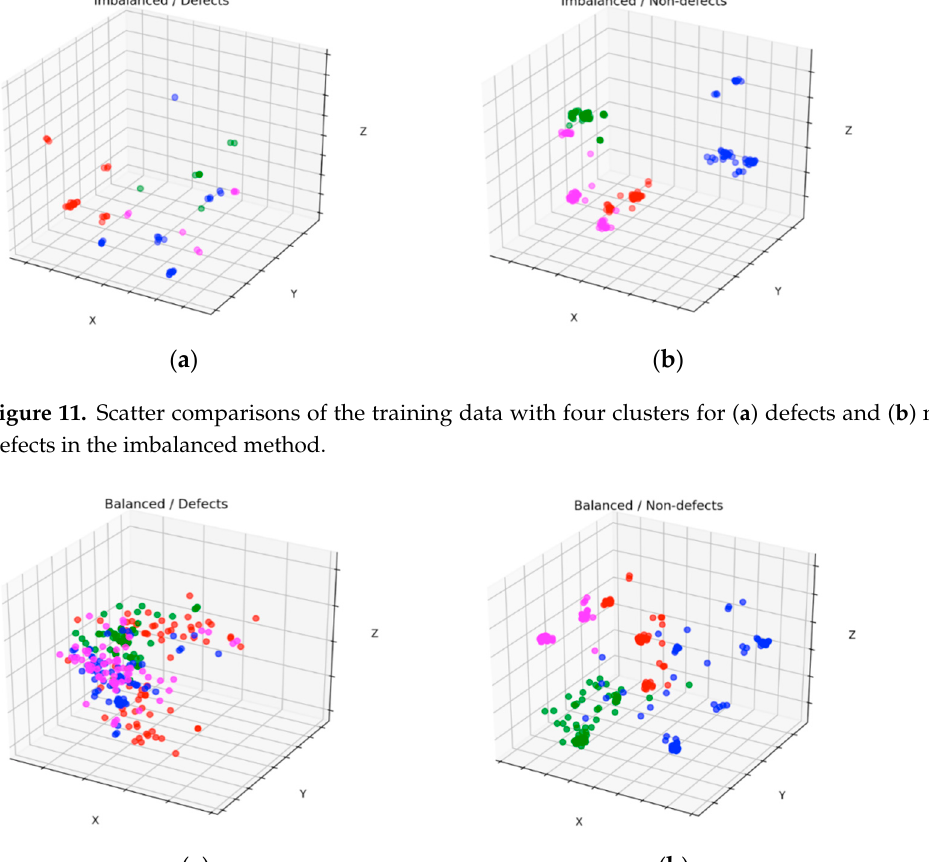
15 of 17 Table 3. Performance evaluation of ceramic substrate defect. Training Setting